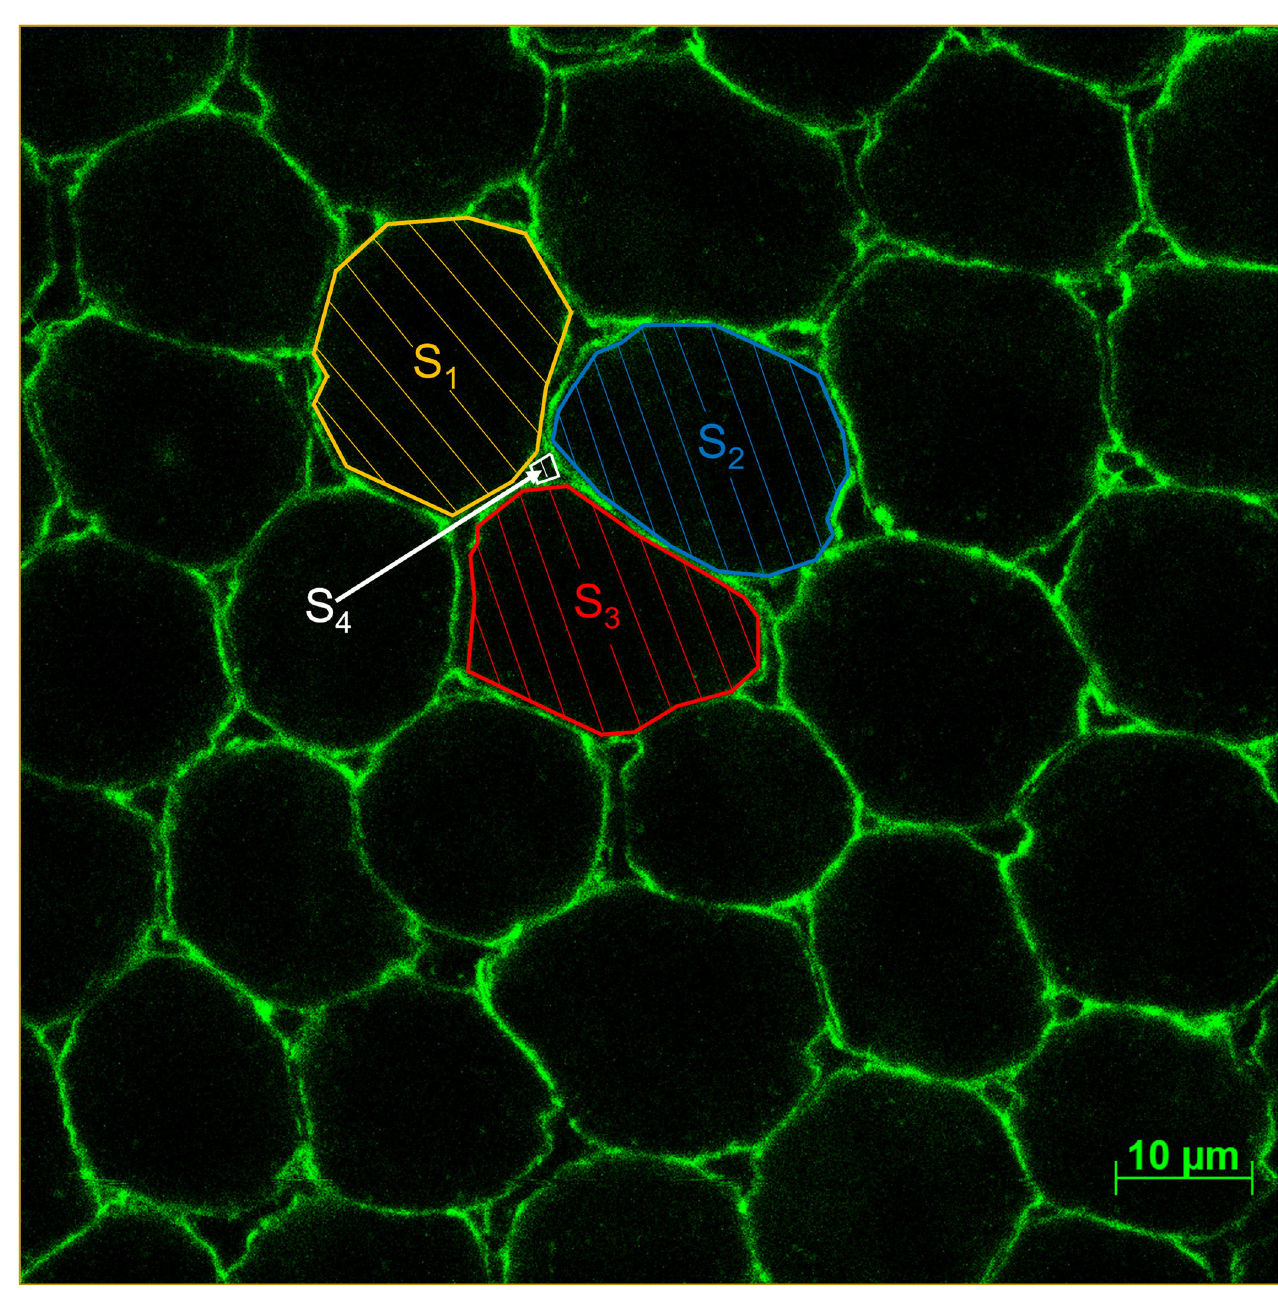
Fig 2. Scheme of follicular epithelium and method of its analysis. S 1 –S 3 follicular cells, S 4 –intercellular space.